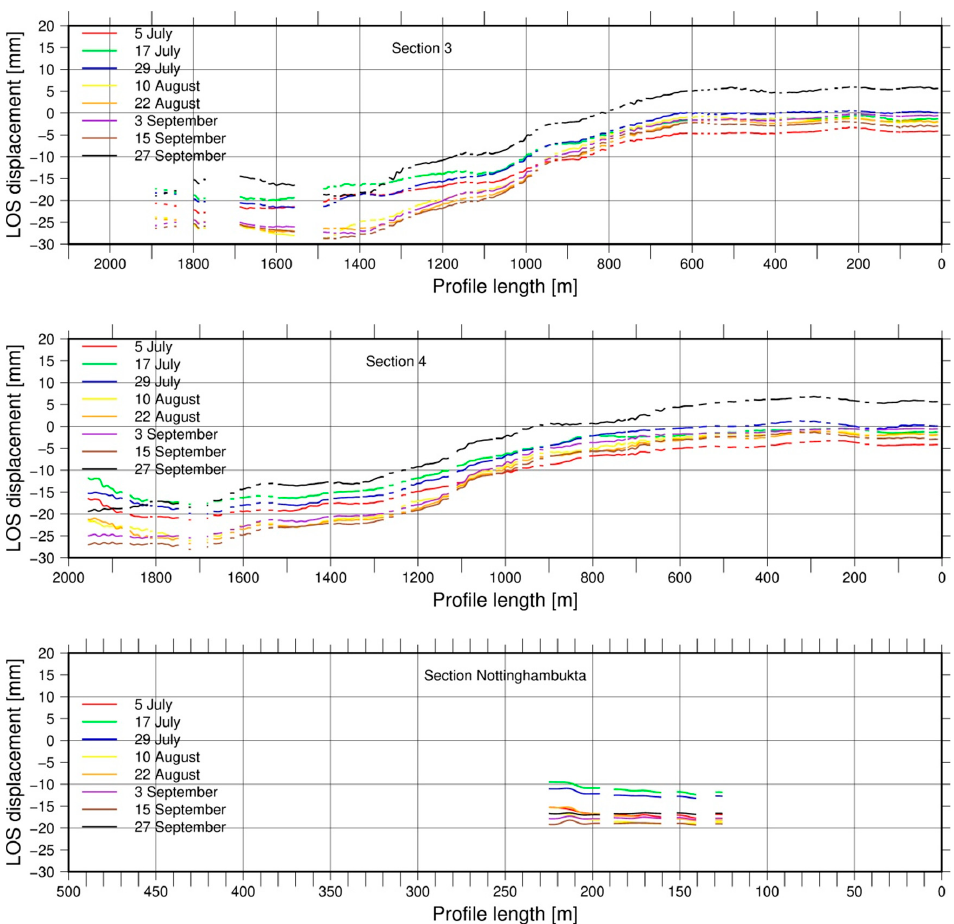
Figure A5. Cross-Sections 1–4 and the Nottingham fan corresponds to electromagnetic measurements in eight time periods.